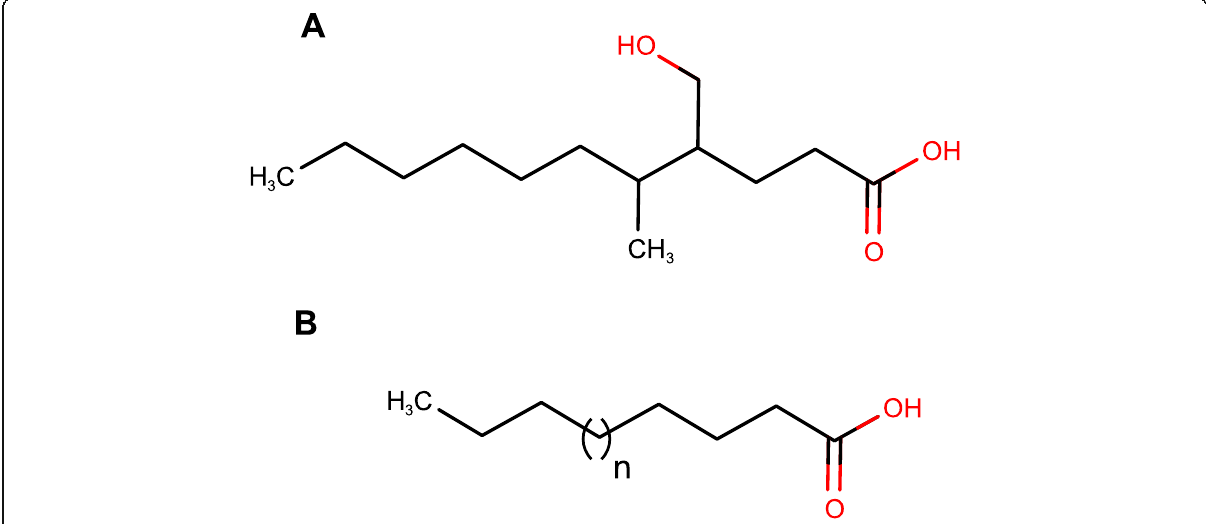
Fig. 5 Proposed chemical structures of the major bioactive compounds from large-scale of Streptomyces sp. MS. 10. a Proposed chemical structure of the major bioactive compound in fraction 8. b Proposed chemical structure of the major bioactive compound in fraction 24